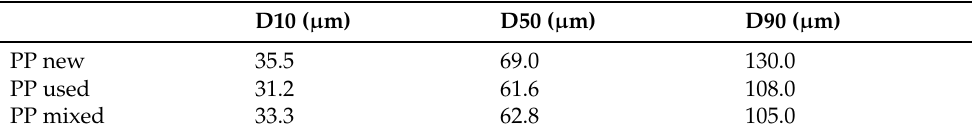
Table 1. Percentile diameter distribution of powder size for new, used and mixed PP powder.